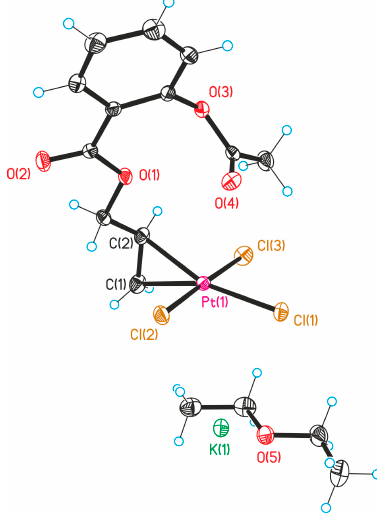
Figure 2. ORTEP drawing of complex 1a .